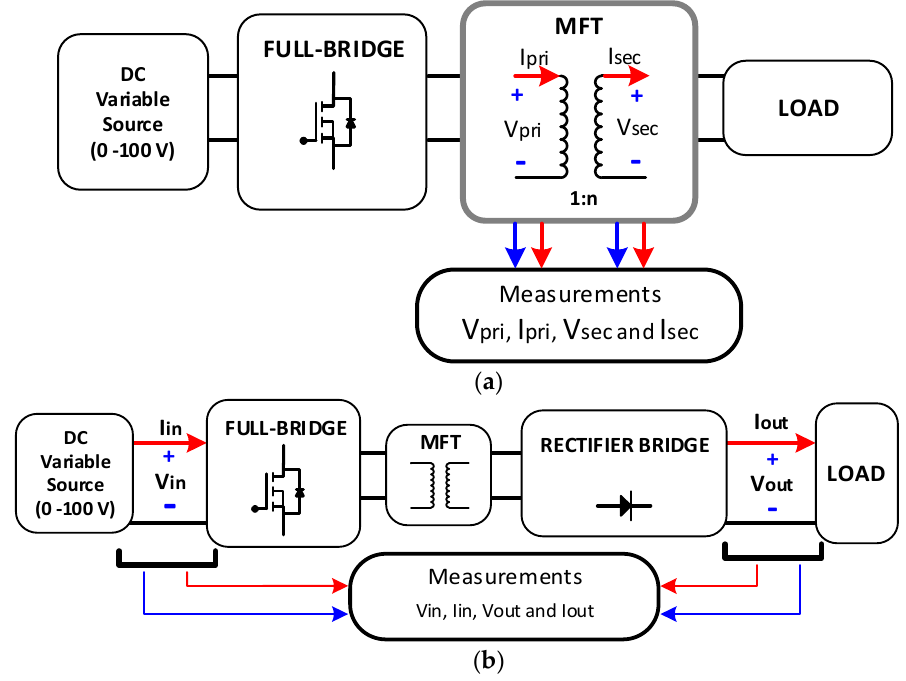
Figure 5. Topology: ( a ) MFT efficiency test and ( b ) FBDC .